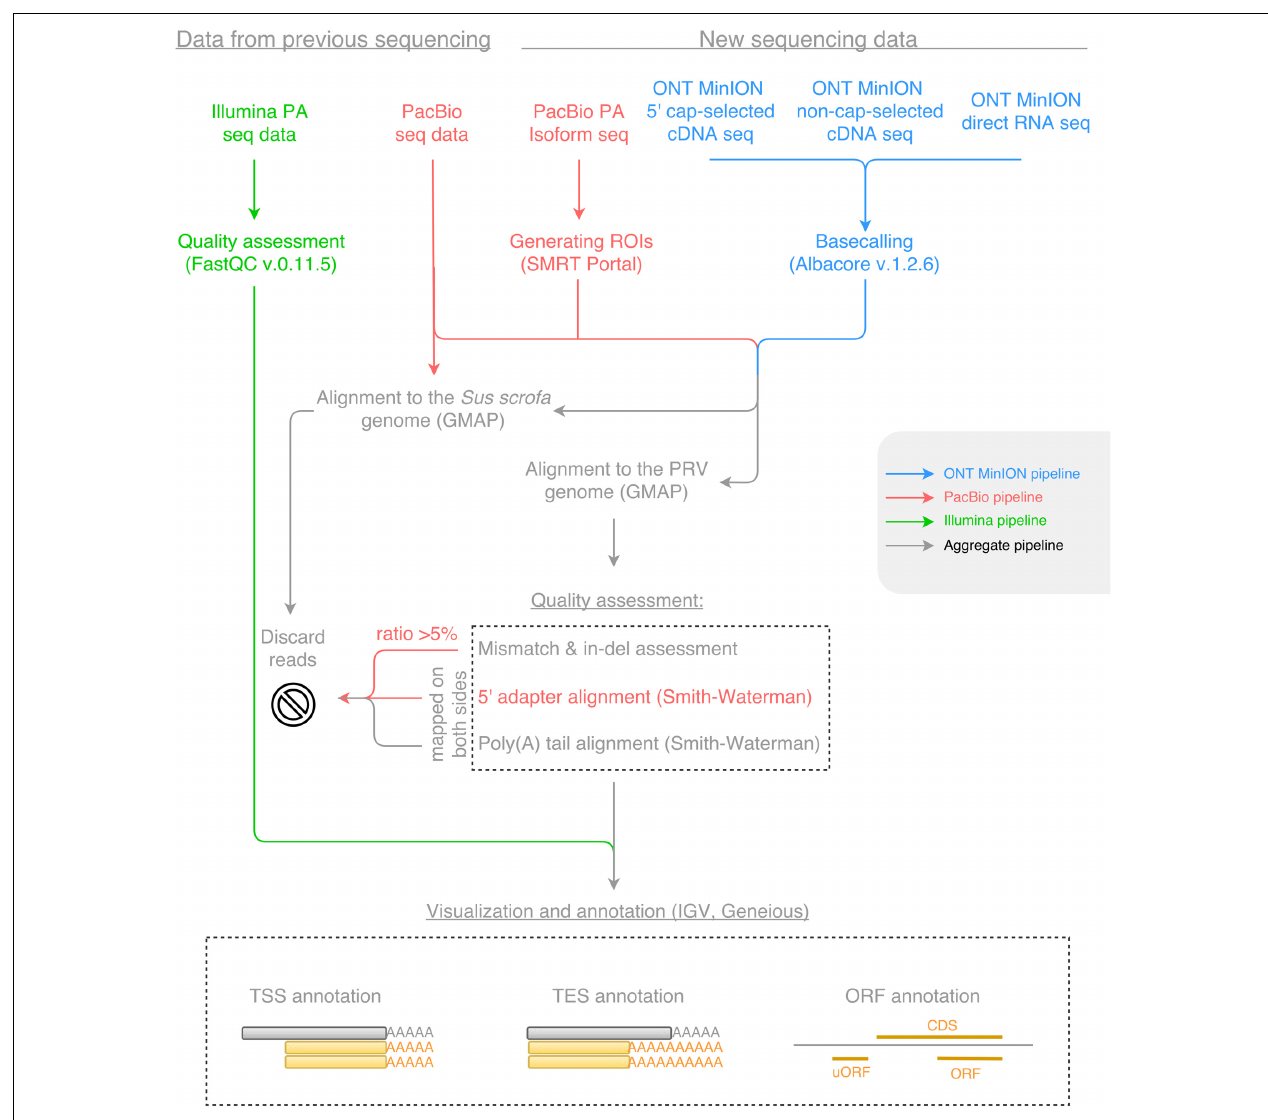
FIGURE 1 | The workflow of data analysis for Illumina, Pacific Biosciences (PacBio) and Oxford Nanopore Technologies (ONT) MinION sequencing datasets. Blue color represents the pipeline for the ONT MinION sequencing data; red color represents the pipeline for the PacBio sequencing data; green color represents the pipeline for the Illumina sequencing data; while gray color represents the aggregate pipeline of all sequencing